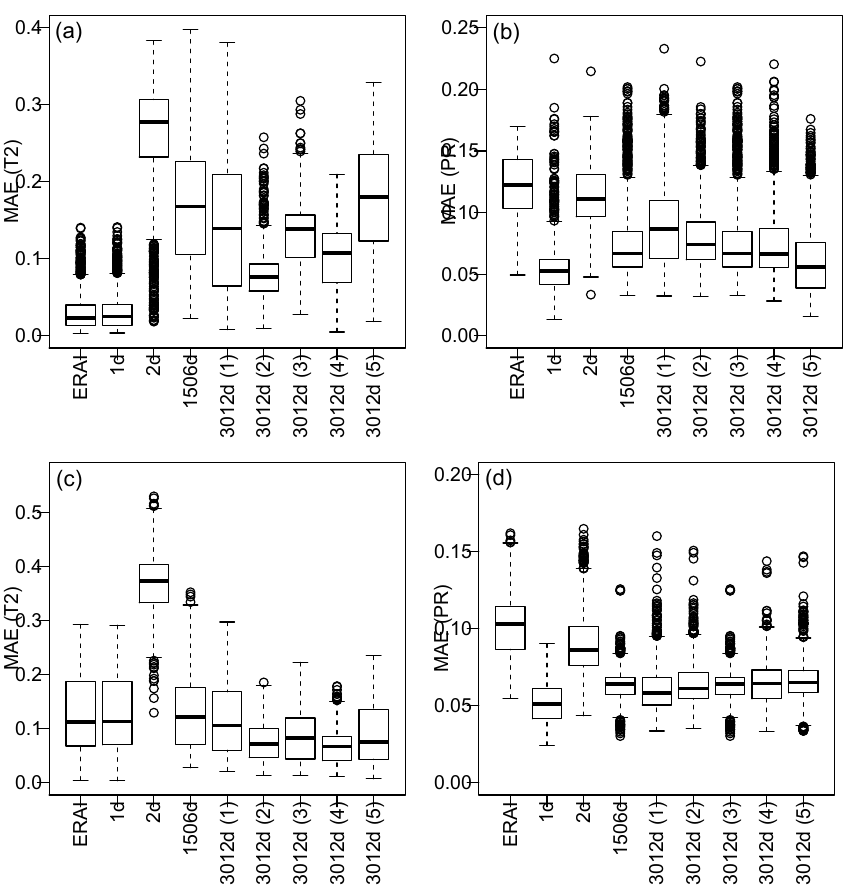
Figure 8. Box plots of the mean absolute error (MAE) values calculated on lag-1 to lag-7 day Pearson correlations for: ERA-I; 1d-BC; 2d-BC; 1506d-BC of T2 or PR (example for first reference variable); 3012d-BC with five different reference temperature locations. (a, c) for 2m-temperature; (b, d) for precipitation; (a, b) winter; (c, d)